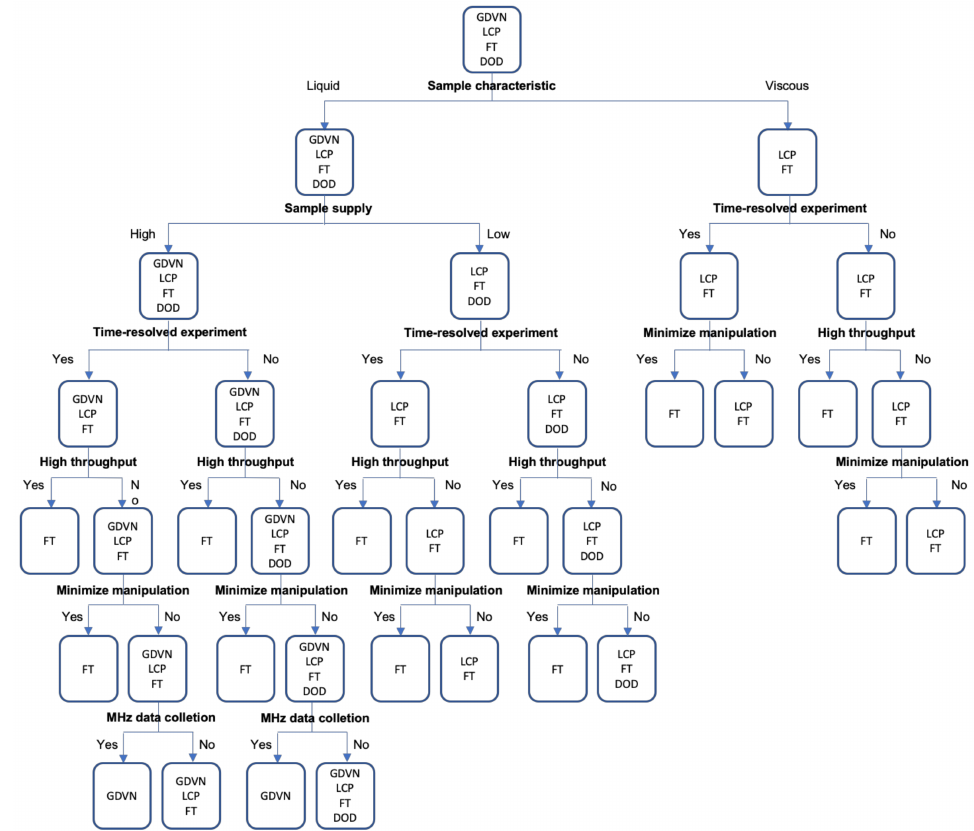
Figure 1. An example of a sample delivery method decision tree. Some major experimental considerations are used here to illustrate options for sample delivery, but likely not including criteria specific to individual sample and experimental requirement. Decisions are suggested based on current knowledge and may not reflect on future development trend. GDVN, gas dynamic virtual nozzle jet; LCP, lipidic cubic phase jet; FT, fixed target support; and DOD,